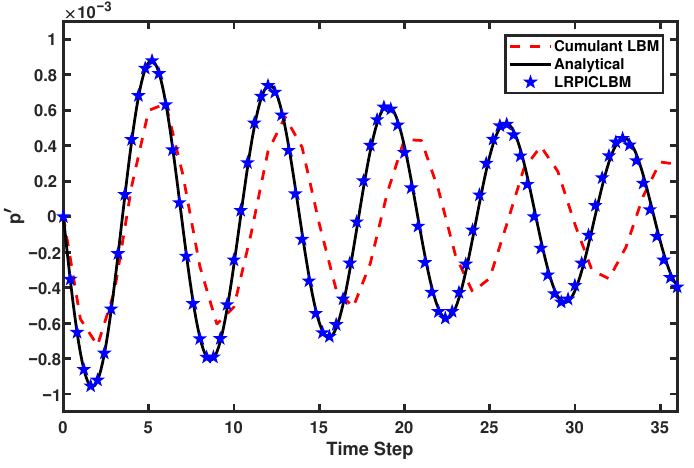
∆ x 2 ∆ t ) with N ppw = 4